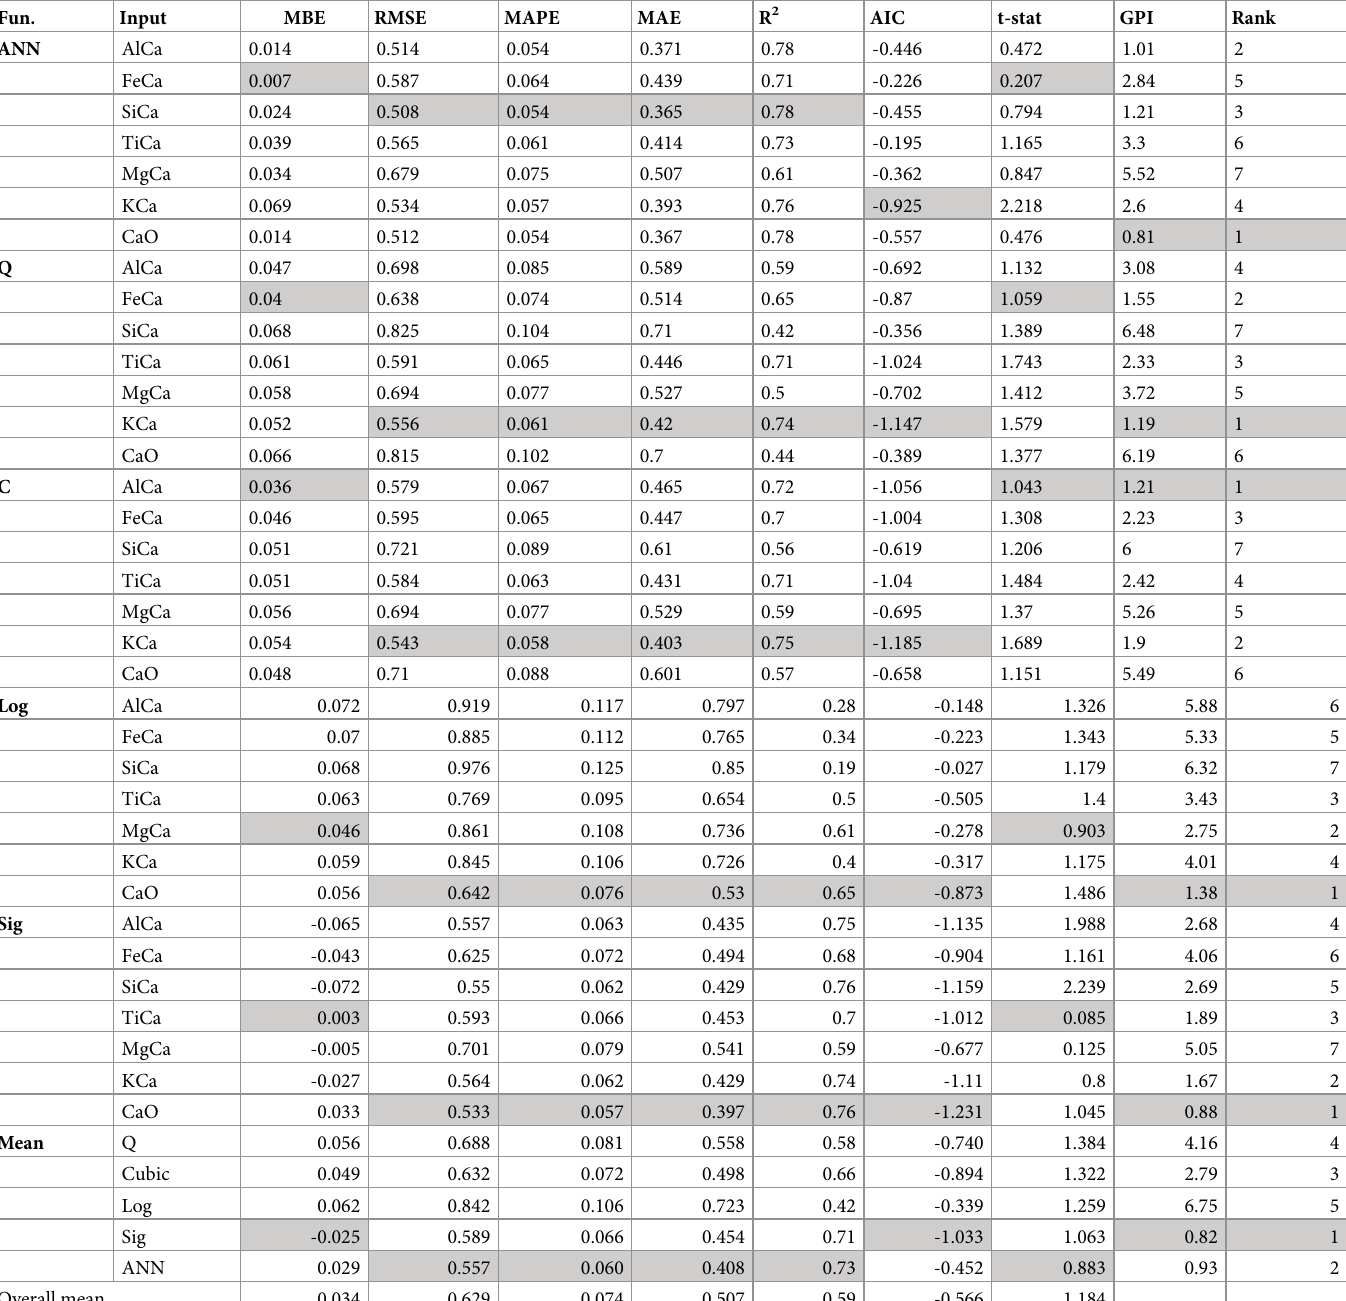
Table 6. Model performance (N =